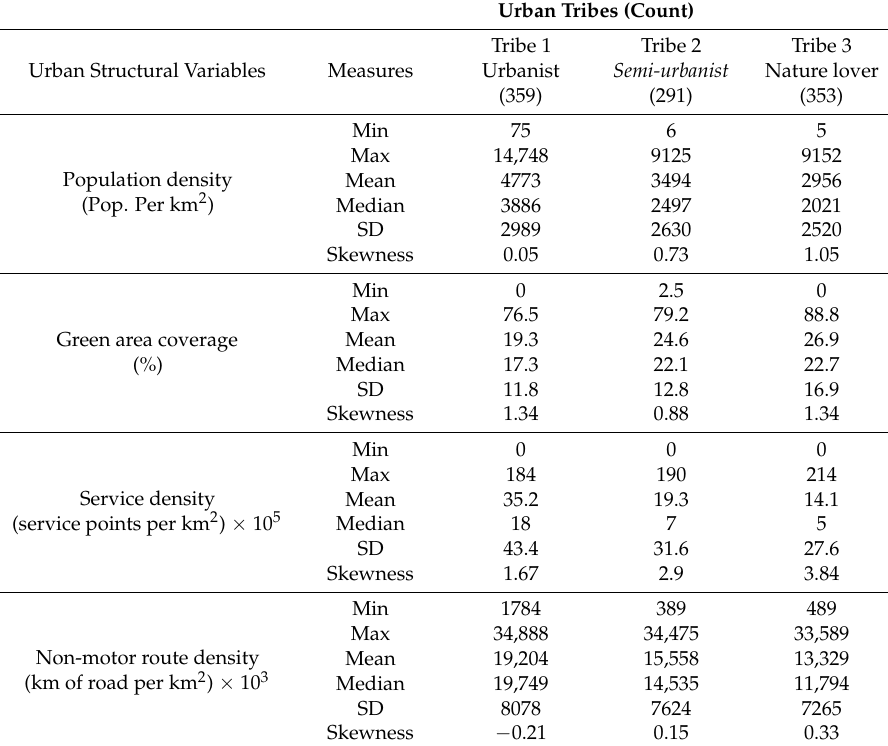
Figure 6. A geographical dominance map of tribes’ dwelling areas. F igure 6. A geographical dominance map of tribes’ dwelling areas. Table 1. Structural variables statistics for the three urban